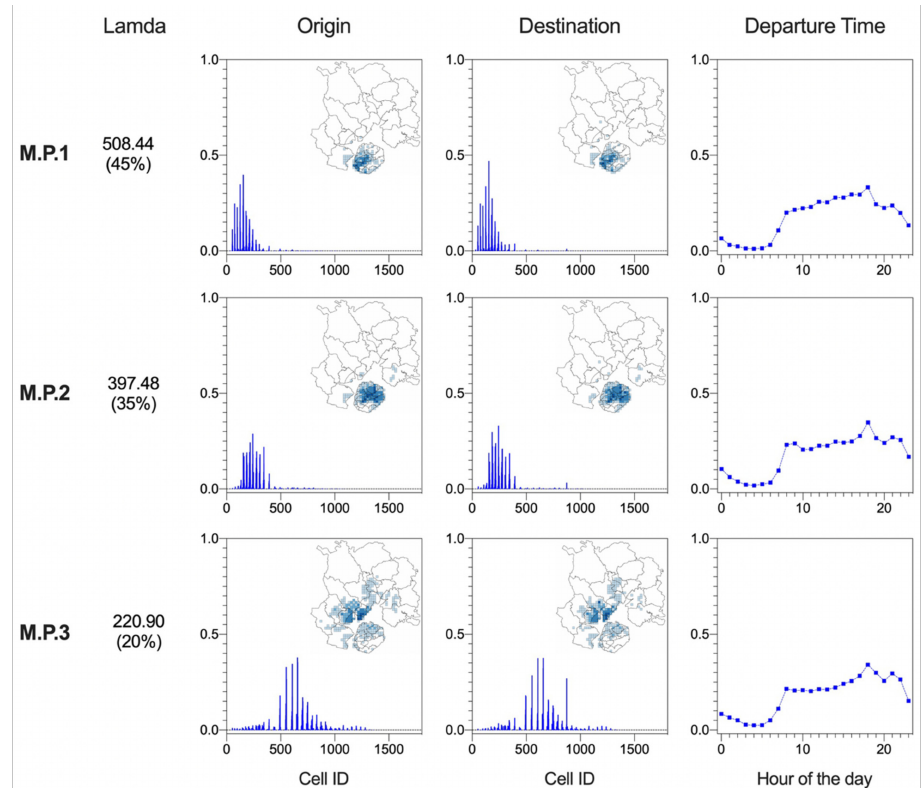
Figure 16. Meta-patterns of ride-hailing mobilities at